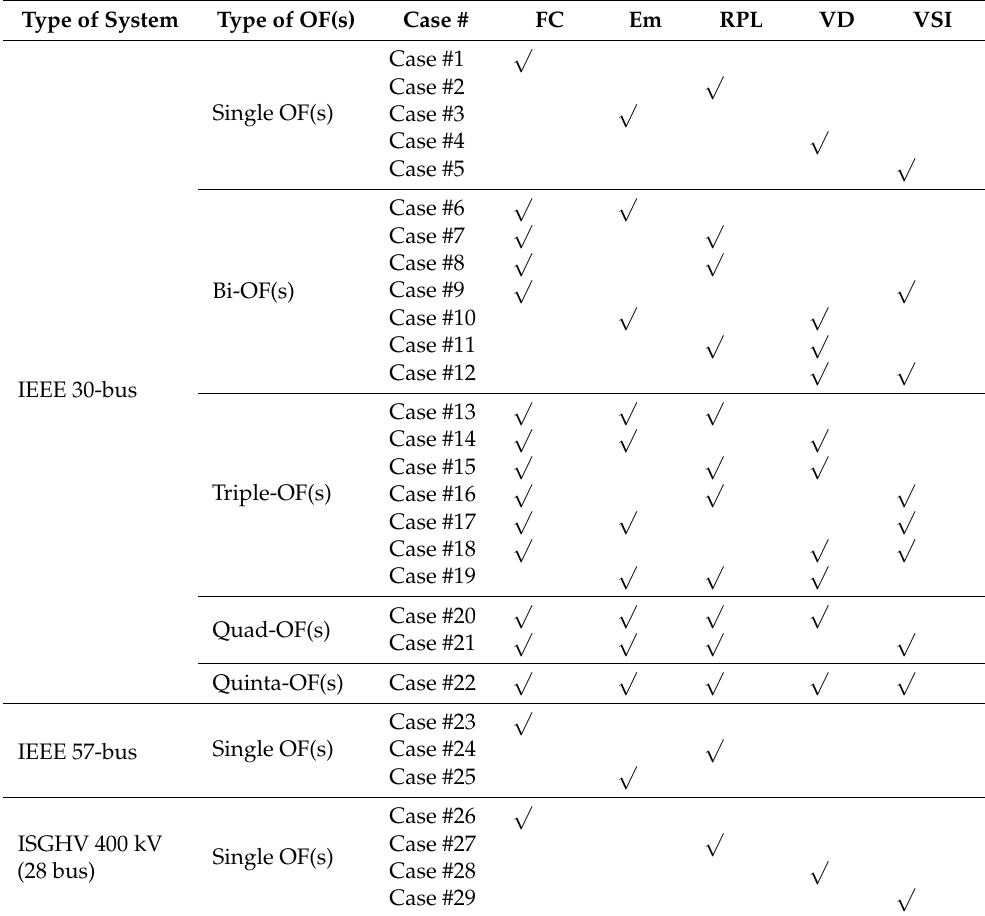
Table 2. Various case